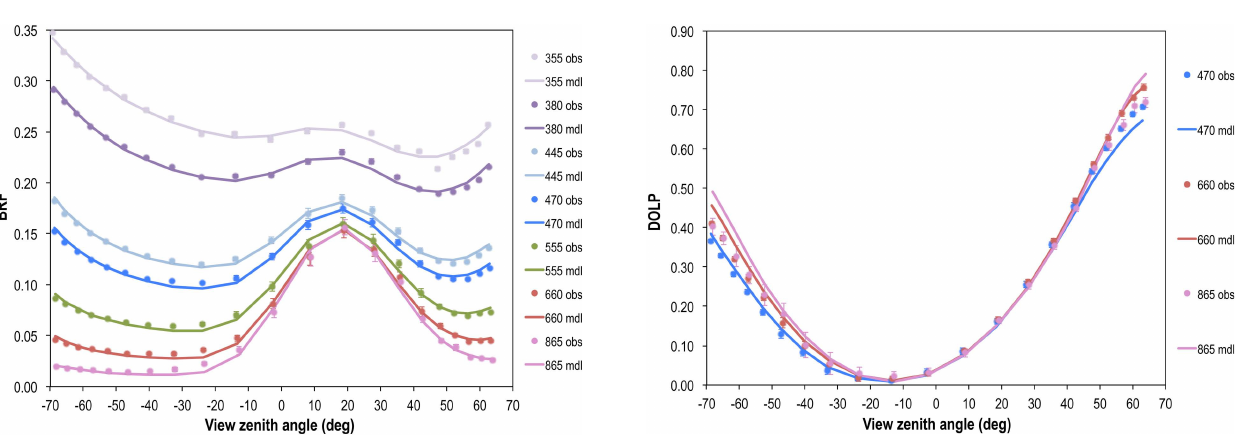
Fig. 9. Comparison of vicariously calibrated BRFs observed in seven AirMSPI bands with results of the coupled atmosphere– surface model. Observations are shown by the circles. Error bars represent the standard deviation in observed BRF within the 100m × 100m target area. Model results are the solid lines. Pos- itively signed view zenith angles are those for which the relative view–Sun azimuth angle is > 90 ◦ or > 270 ◦ ; otherwise the view zenith angle is given a negative sign.